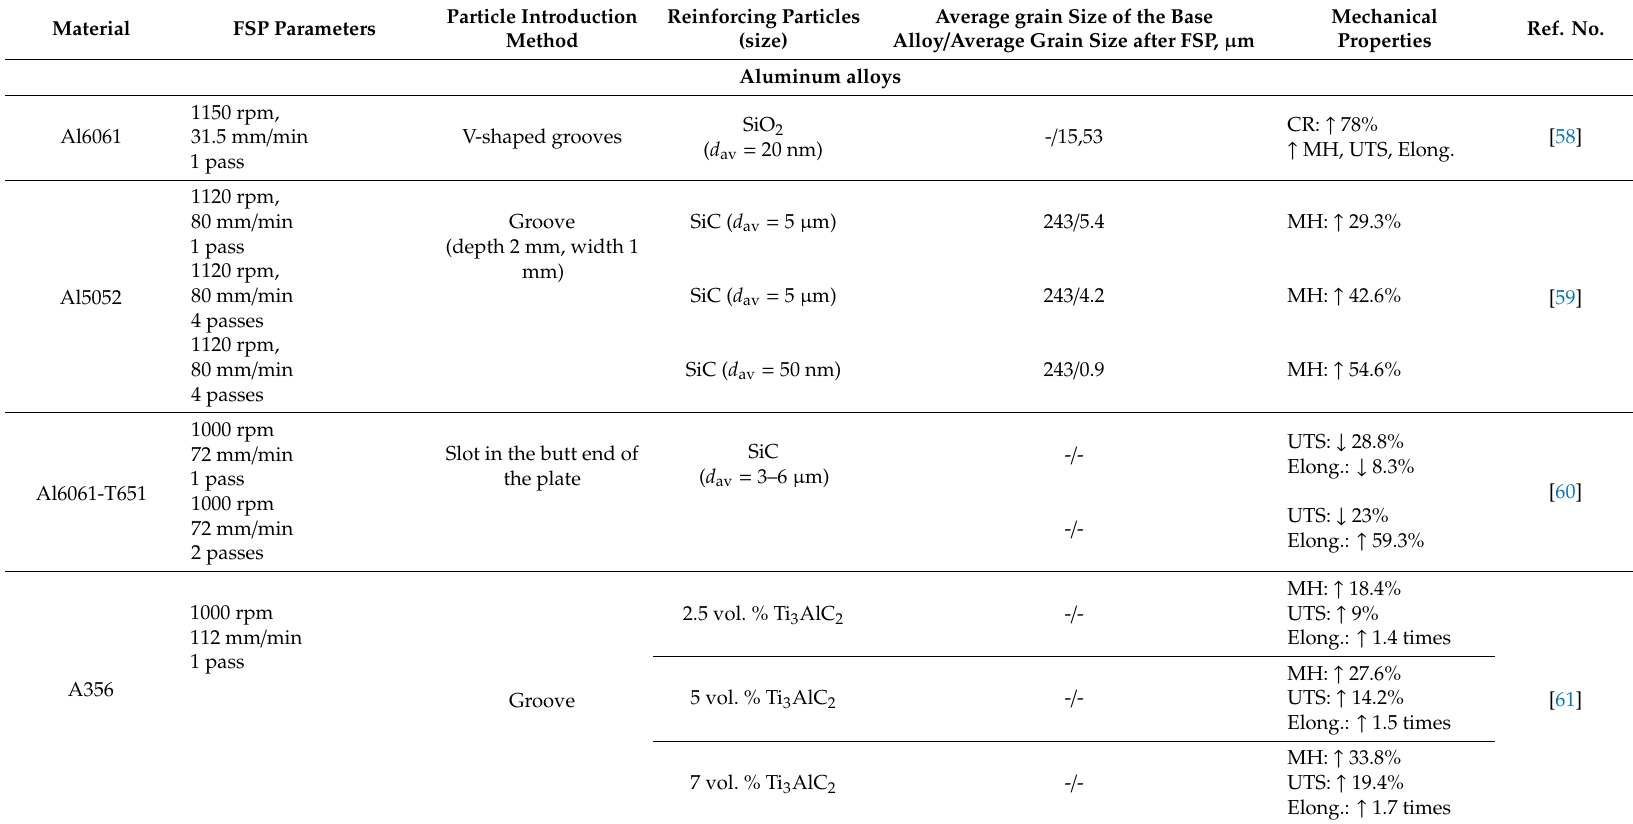
Table 5. Experimental data on FSP of particle-reinforced structural